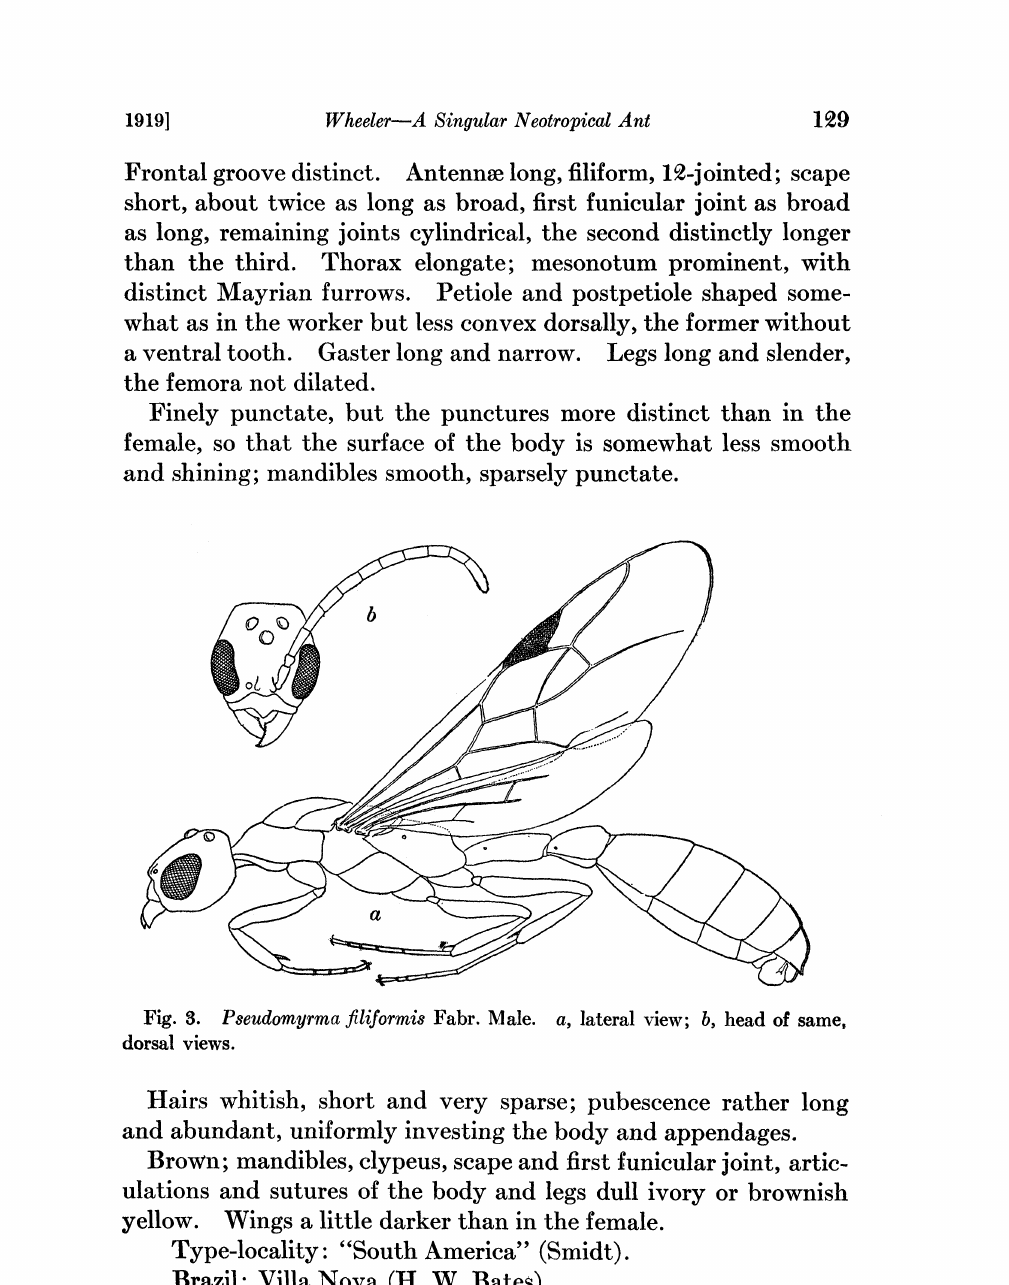
Fig. 8. Pseudomyrma filiformis Fabr. Male. a, lateral view; b, head of same, dorsal views. Hairs whitish, short and very sparse; pubescence rather long and abundant, uniformly investing the body and appendages. Brown; mandibles, clypeus, scape and first funicular joint, artic- ulations and sutures of the body and legs dull ivory or brownish